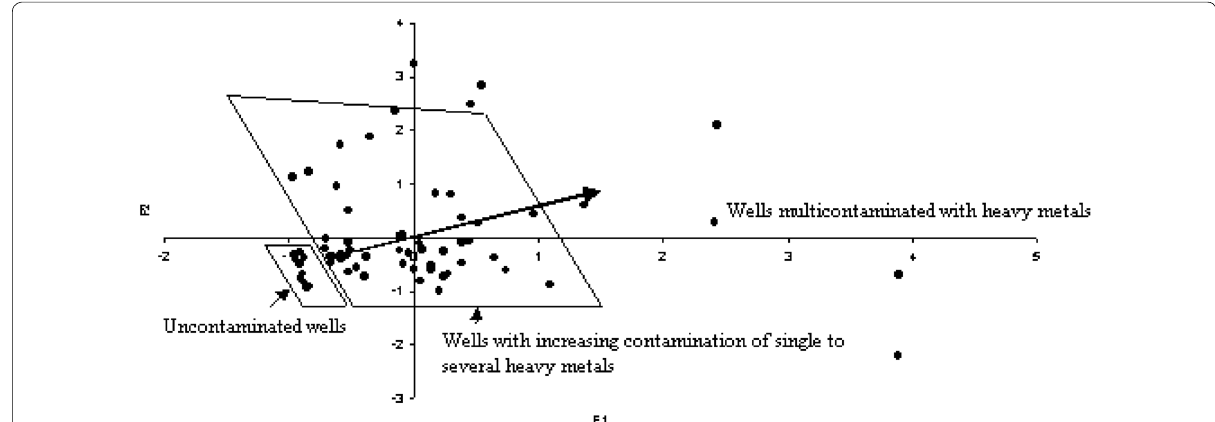
Fig. 3 Distribution of variables given by the factor